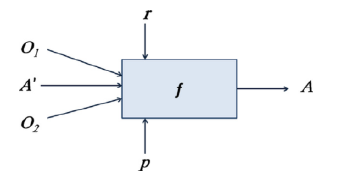
Figure 3. The Flowchart of Ontology Matching